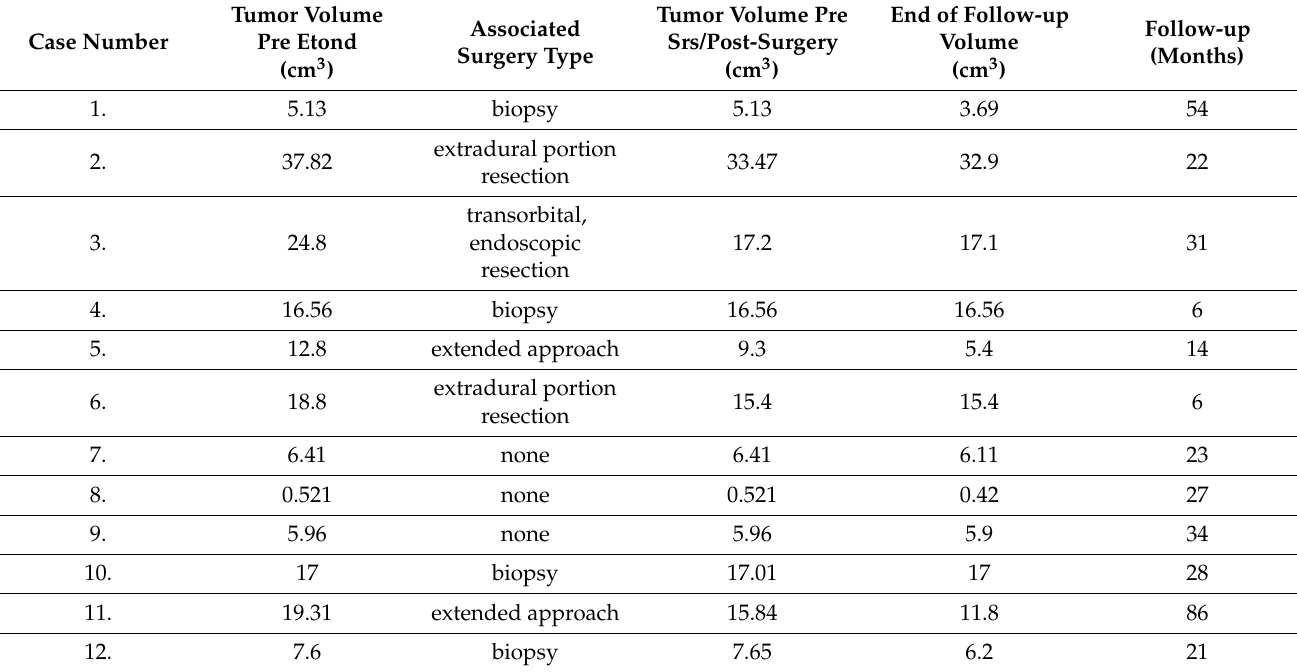
Table 3. Tumor volume and development over the monitoring